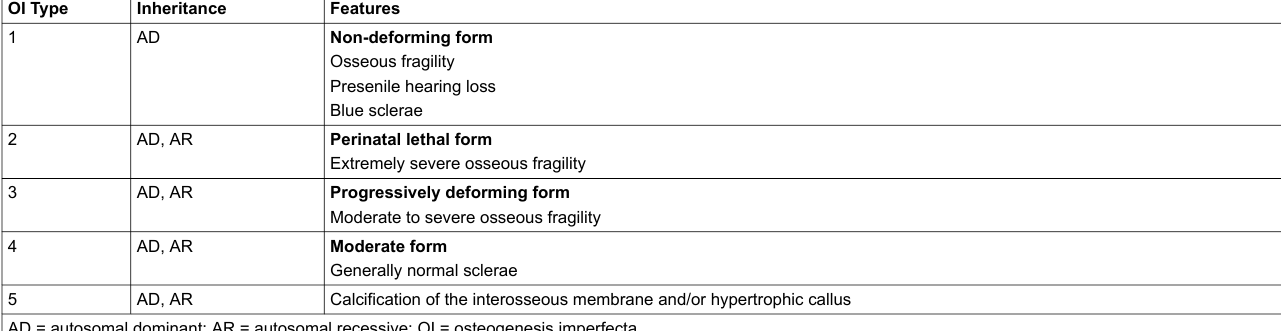
Table 4: Pre- and postnatal severity grading scale (adapted from Van Dijk FS, Sillence DO. Osteogenesis imperfecta: Clinical diagnosis, nomenclature and severity assessment. Am J Med Genet A. 2014;164A:1470–81). Intrauterine (ultrasound at 20 weeks of